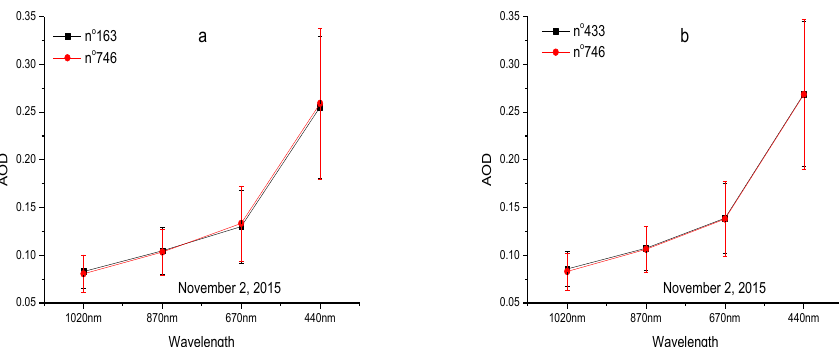
Figure 2. Comparison of the result of AOD retrieved at 1020 nm, 870 nm, 670nm and 440 nm from the measurements of ( a ) n°163 and n°746, and ( b ) n°433 and n°746.